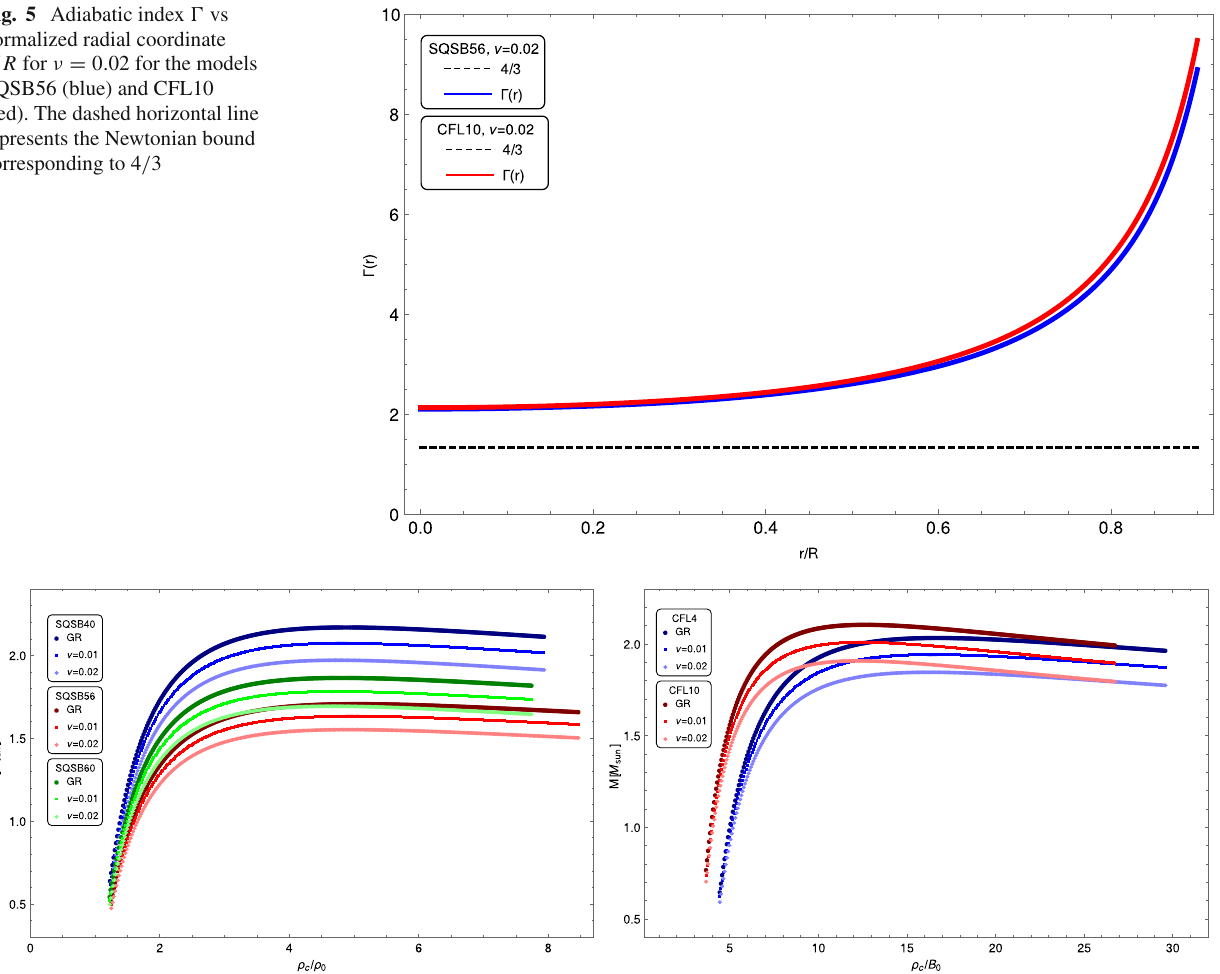
Fig. 6 Mass of the star (in solar masses) vs normalized central energy density for GR ( ν = 0) as well as for ν = 0 . 01 , 0 . 02. Left panel Mass vs ρ /ρ c 0 for the 3 MIT bag models, SQSB40 (blue), SQSB56 (red) and SQSB60 (green). Right panel Mass vs (blue) and CFL10